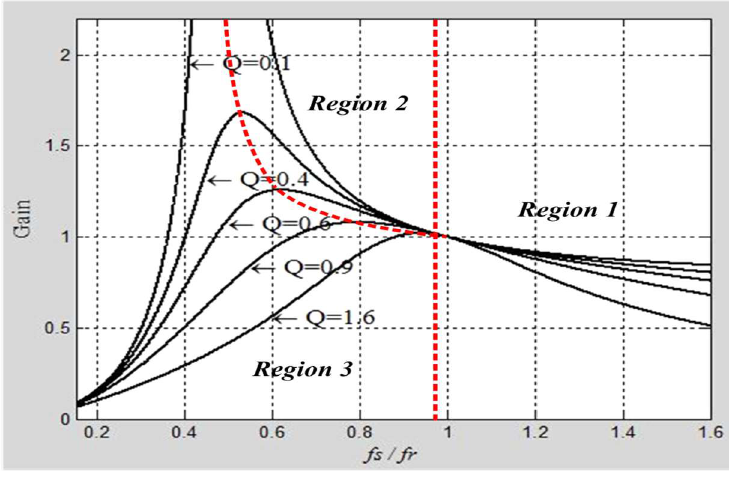
Figure 4. Operation regions for Half bridge LLC converter [43].